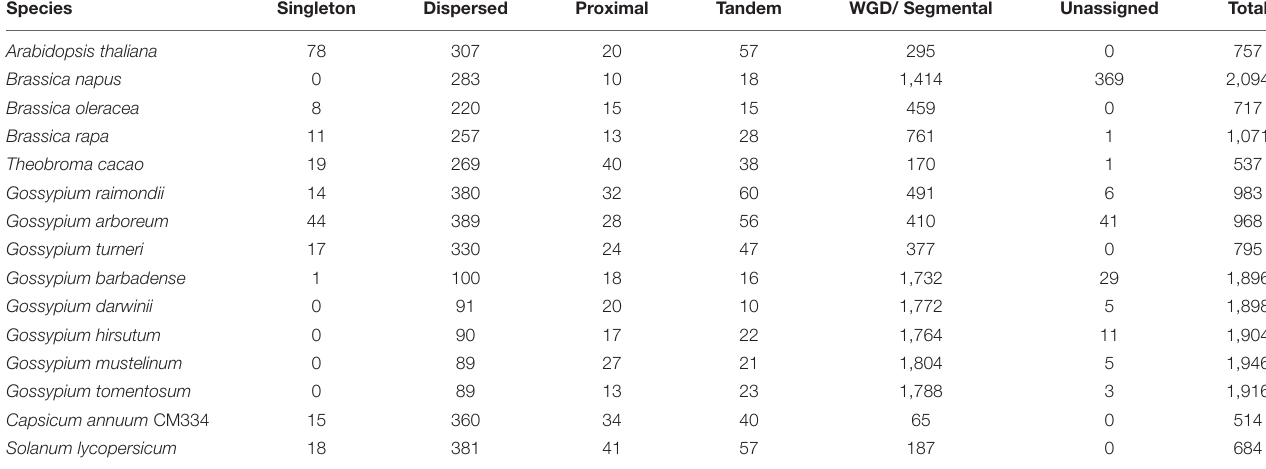
TABLE 3 | Classification of duplicated